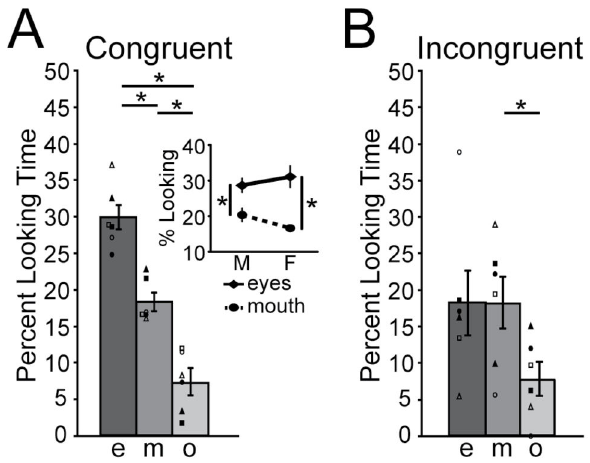
Figure 3. Scanning Patterns. Percentages of looking time (± s.e.m.) to the eyes (e), mouth (m), and other (o) of the congruent stimulus video (A), the incongruent stimulus video (B). Inset in A: Percentages of looking time (± s.e.m.) to the eyes (diamonds/solid line) and mouth (circles/dashed line) of the congruent stimulus video in for males and females. (*) p ≤